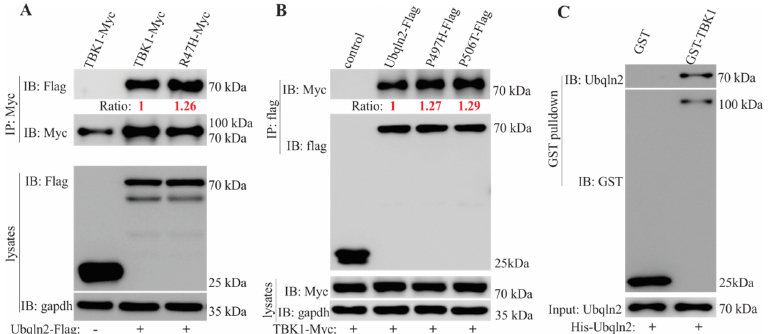
Figure 1. TANK-binding kinase 1 (TBK1) interacts with Ubiquilin 2 (UBQLN2). ( A – B ) Immunoprecipitation (IP) revealed that TBK1 interacted with UBQLN2 in HEK-293T cells when co-transfected with plasmids (Myc-tagged TBK1 and Flag-tagged UBQLN2) using Lipofectamine 2000. The transfected cells were harvested 48 h after transfection. The ratios in panel A were calculated based on the pull-downs of myc-tagged baits, and in panel B, these ratios were calculated according to the pull-down of the Myc or Flag-tagged bait protein Control: GFP tagged with Flag. ( C ) Glutathione-S-transferase (GST) pull-down assay revealed that UBQLN2 bound to TBK1 in vitro. Recombinant UBQLN2 protein was incubated with GST or GST-TBK1 protein for 2 h, and GST was then pulled down with glutathione-agarose beads. Proteins in the precipitates were detected by immunoblot with UBQLN2 and GST antibodies. Cells 2020 , 9 , x FOR PEER REVIEW